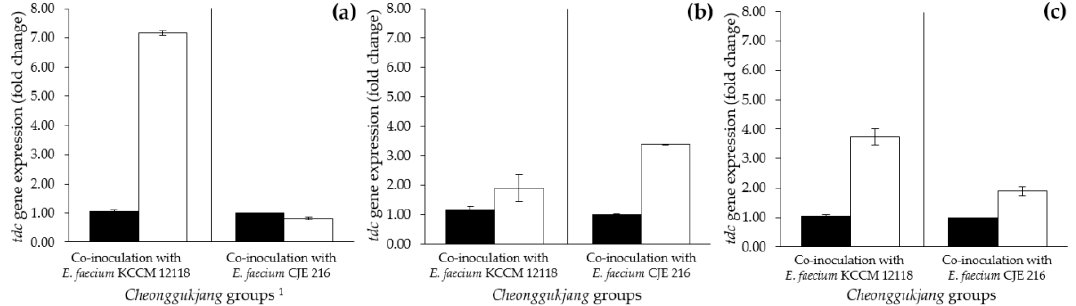
Figure 6. Effect of fermentation temperature on tdc expression by E. faecium strains in Cheonggukjang on ( a ) day 1, ( b ) day 2, and ( c ) day 3 of fermentation. ■ : 37 °C, □ : 45 °C. 1 Cheonggukjang groups were co-inoculated with B. subtilis (KCTC 3135) and E. faecium (KCCM 12118 or CJE 216) strains. The expression levels observed in groups fermented at 45 °C were normalized to those detected in the corresponding groups fermented at 37 °C. Expression of tdc gene was not detected in Cheonggukjang fermented at 25 °C. Error bars indicate standard deviations calculated from duplicate experiments.